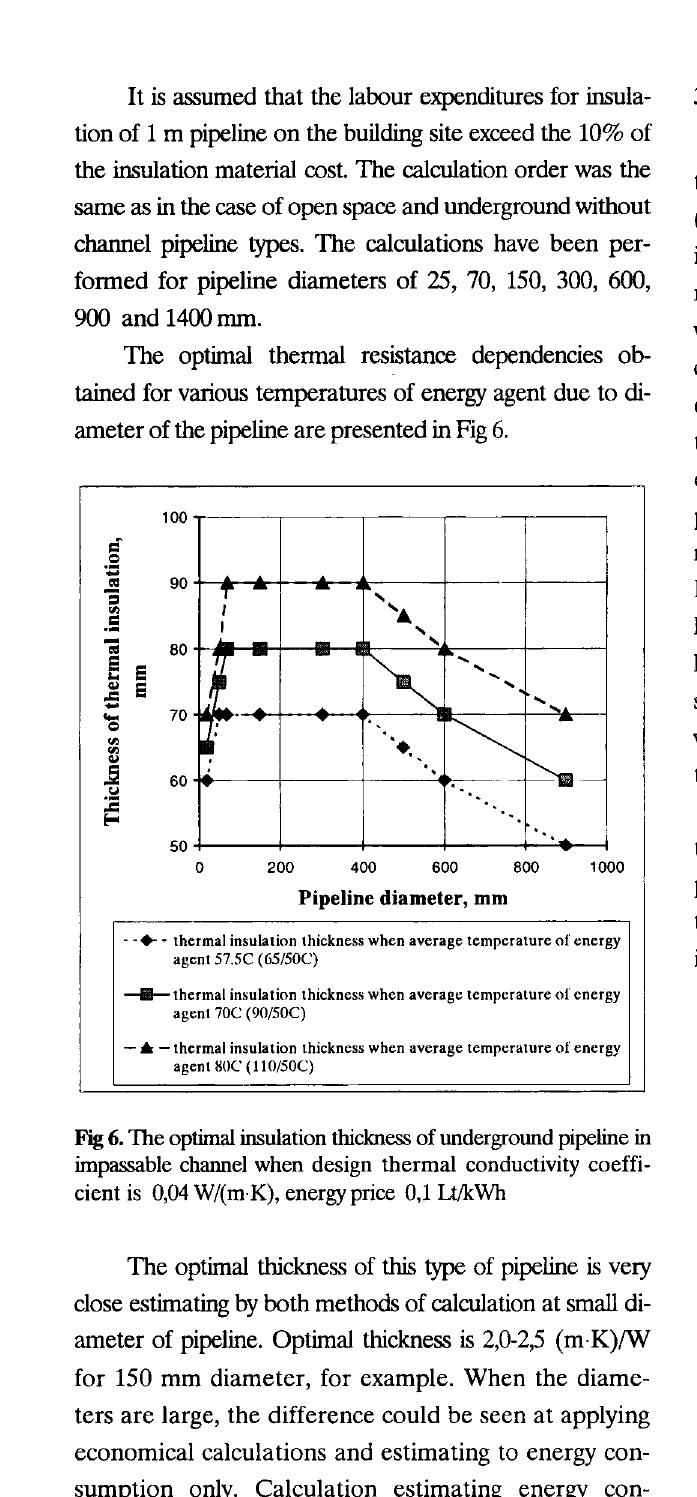
Fig 6. The optimal insulation thiclmess of underground pipeline in impassable channel when design thermal conductivity coeffi cient is 0,04 W/(mK), energy price 0,1 Lt/kWh